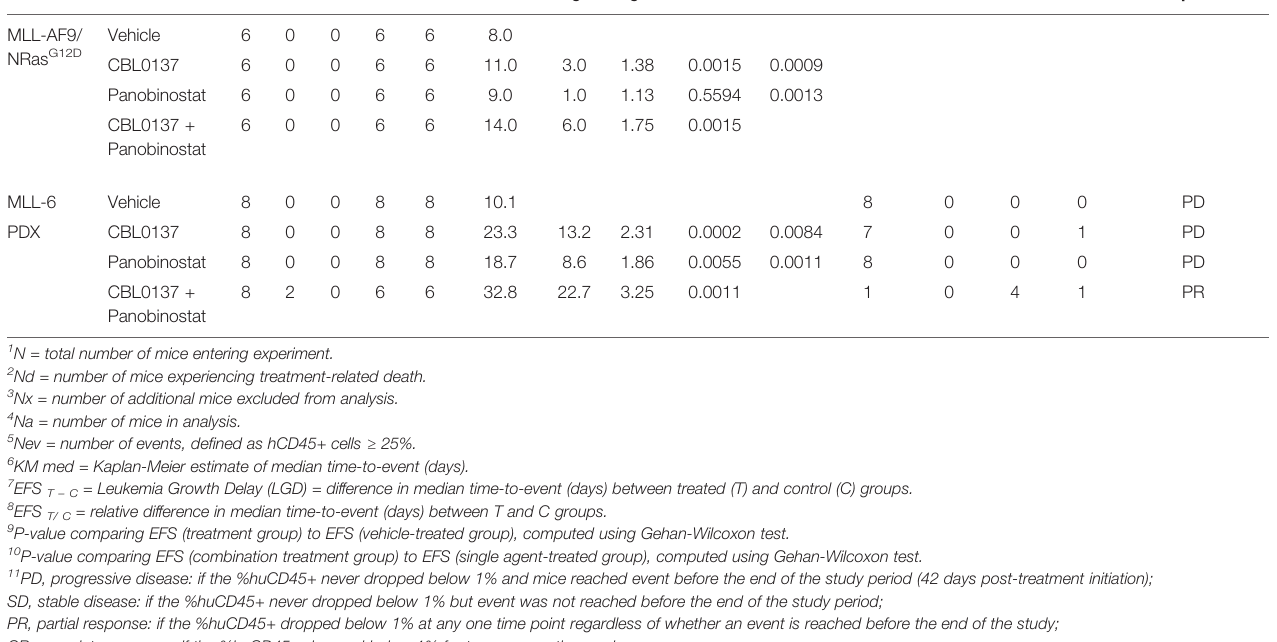
TABLE 1 | Summary of in vivo ef fi cacy of CBL0137 combined with panobinostat. Treatment Animal Counts/Status EFS Group